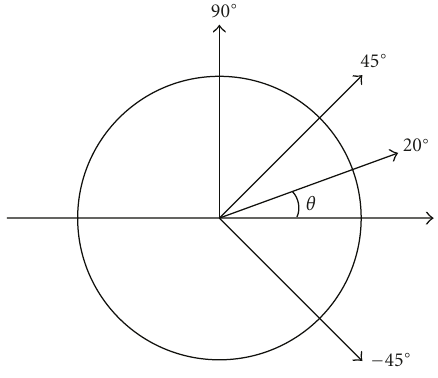
Figure 2: Rotation